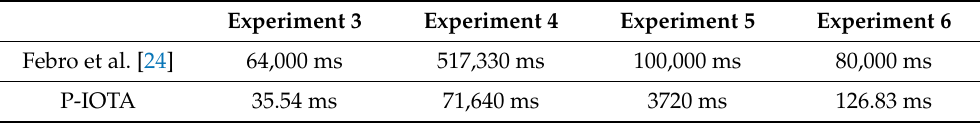
Table 2. Comparison between P-IOTA and Febro et al.